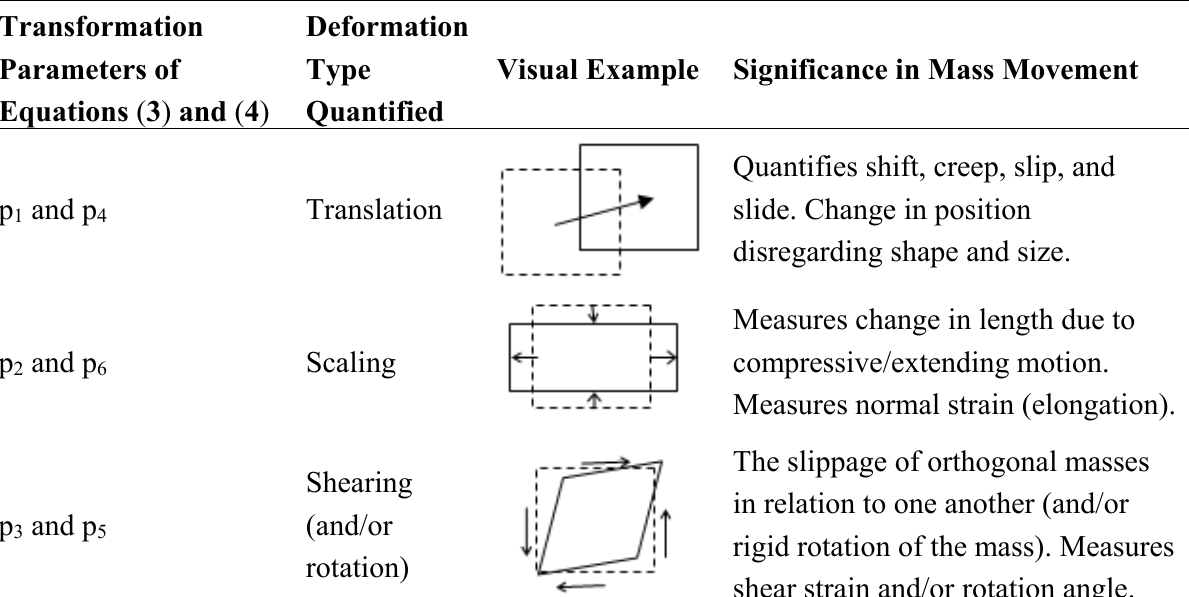
Table 1. Parameters of the spatial transformation models related to mass movement